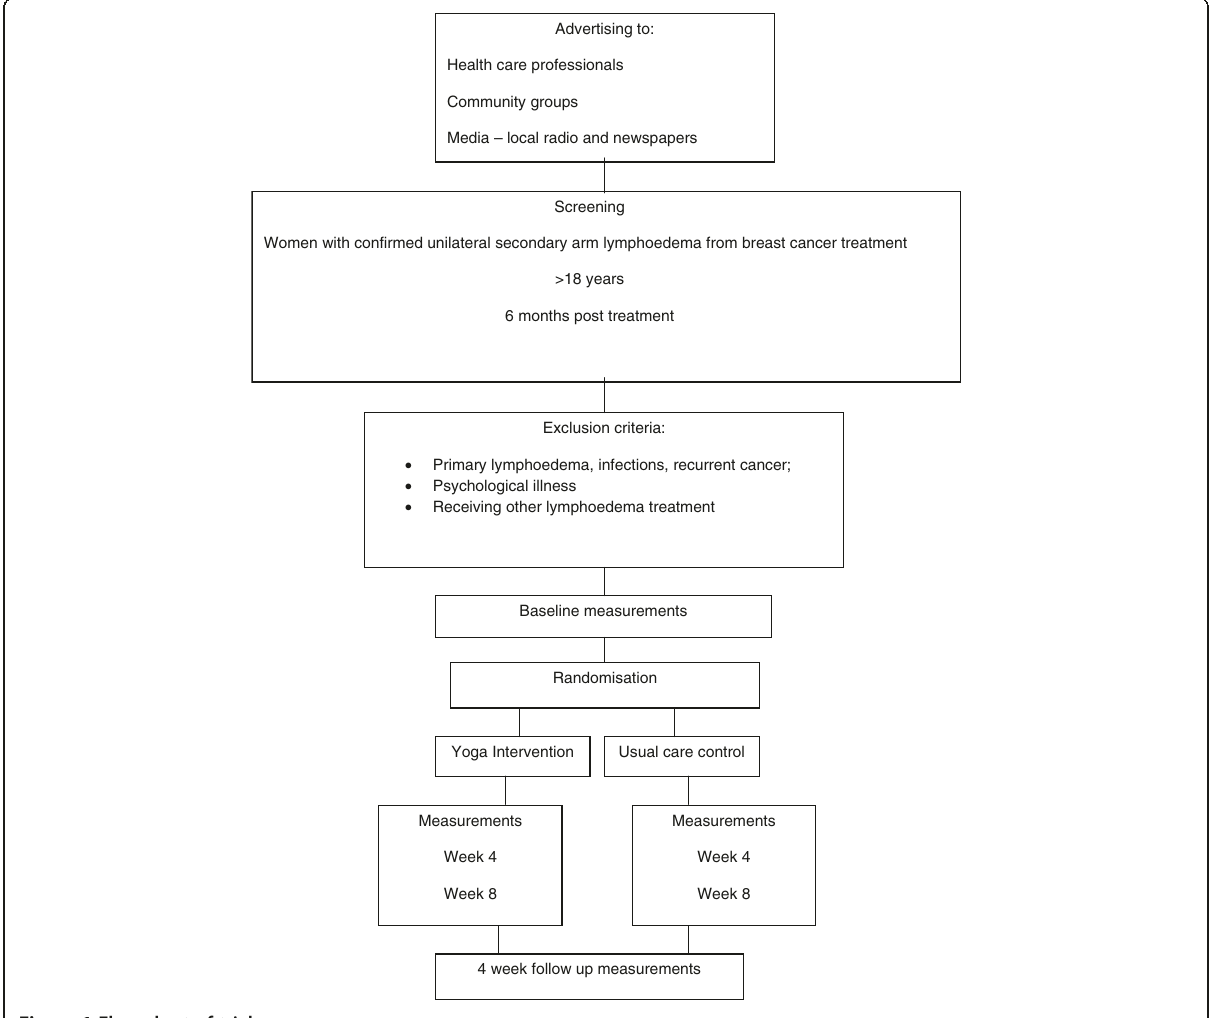
Figure 1 Flow chart of